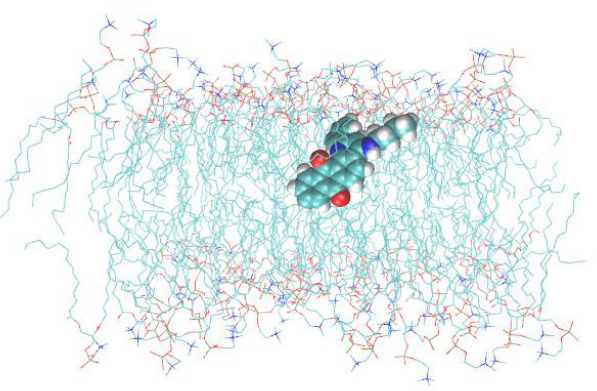
Figure 6. Snapshot of the MD trajectory of Q1 in the box with DMPC bilayer. Water molecules are not shown.